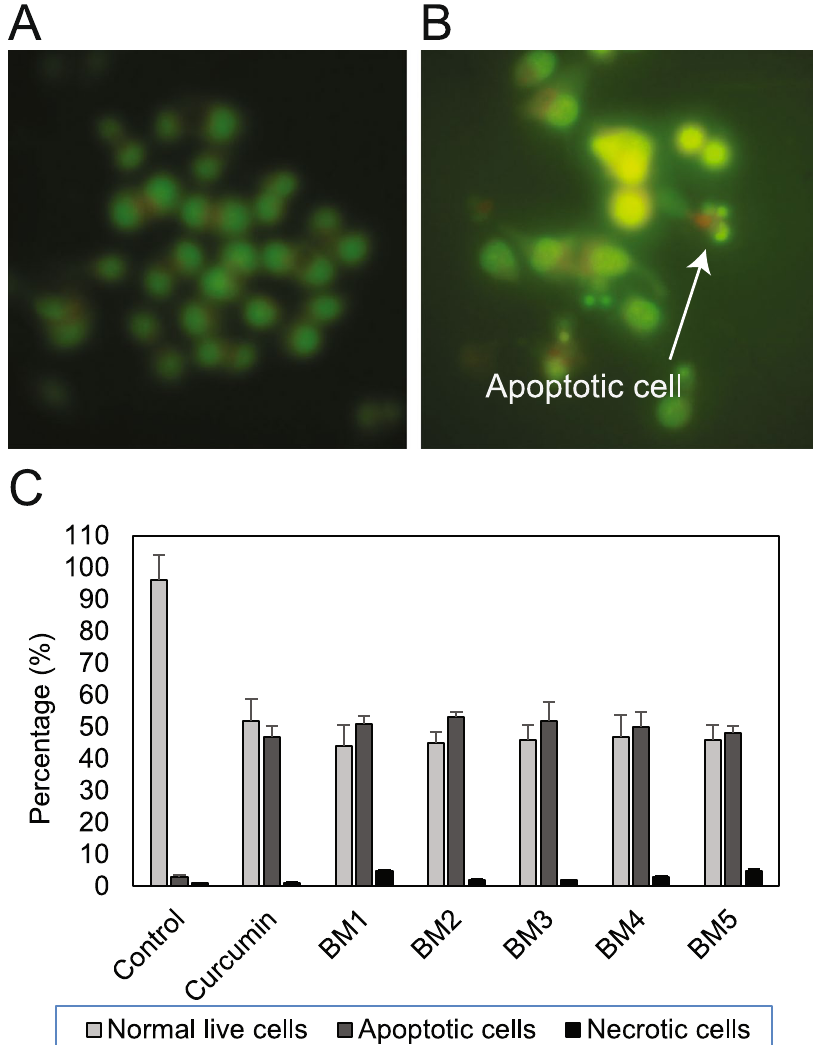
Figure 6. EB/AO staining for detecting apoptotic cells. ( A ) Control un-treated AGS cells. ( B ) Representative micrograph of apoptotic cells treated with BM2 that are characterized with fragmented and condensed nuclei of cells. ( C ) Quantification of the cells with normal, necrotic and apoptotic representation.